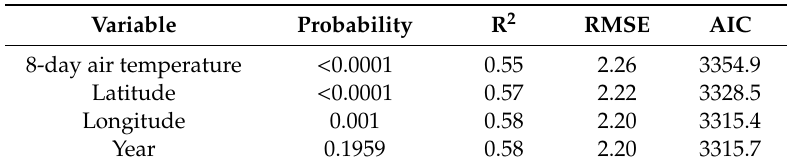
Table 4. Results of a stepwise forward multiple regression for the Canadian lakes. The variables are listed in the order of their selection for the model and for each variable we have listed the probability that it is statistically significant, the coe ffi cient of determination (R 2 ), the root-mean-squared-error (RMSE) and the Akaike information criterion (AIC).